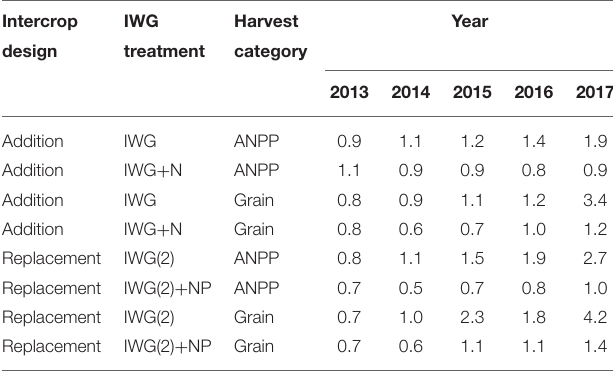
TABLE 1 | Relative Yield a (RY) ratios of IWG ANPP grain yields grown in addition replacement intercrop designs with alfalfa (IWG-ALF) relative to four monocrop IWG